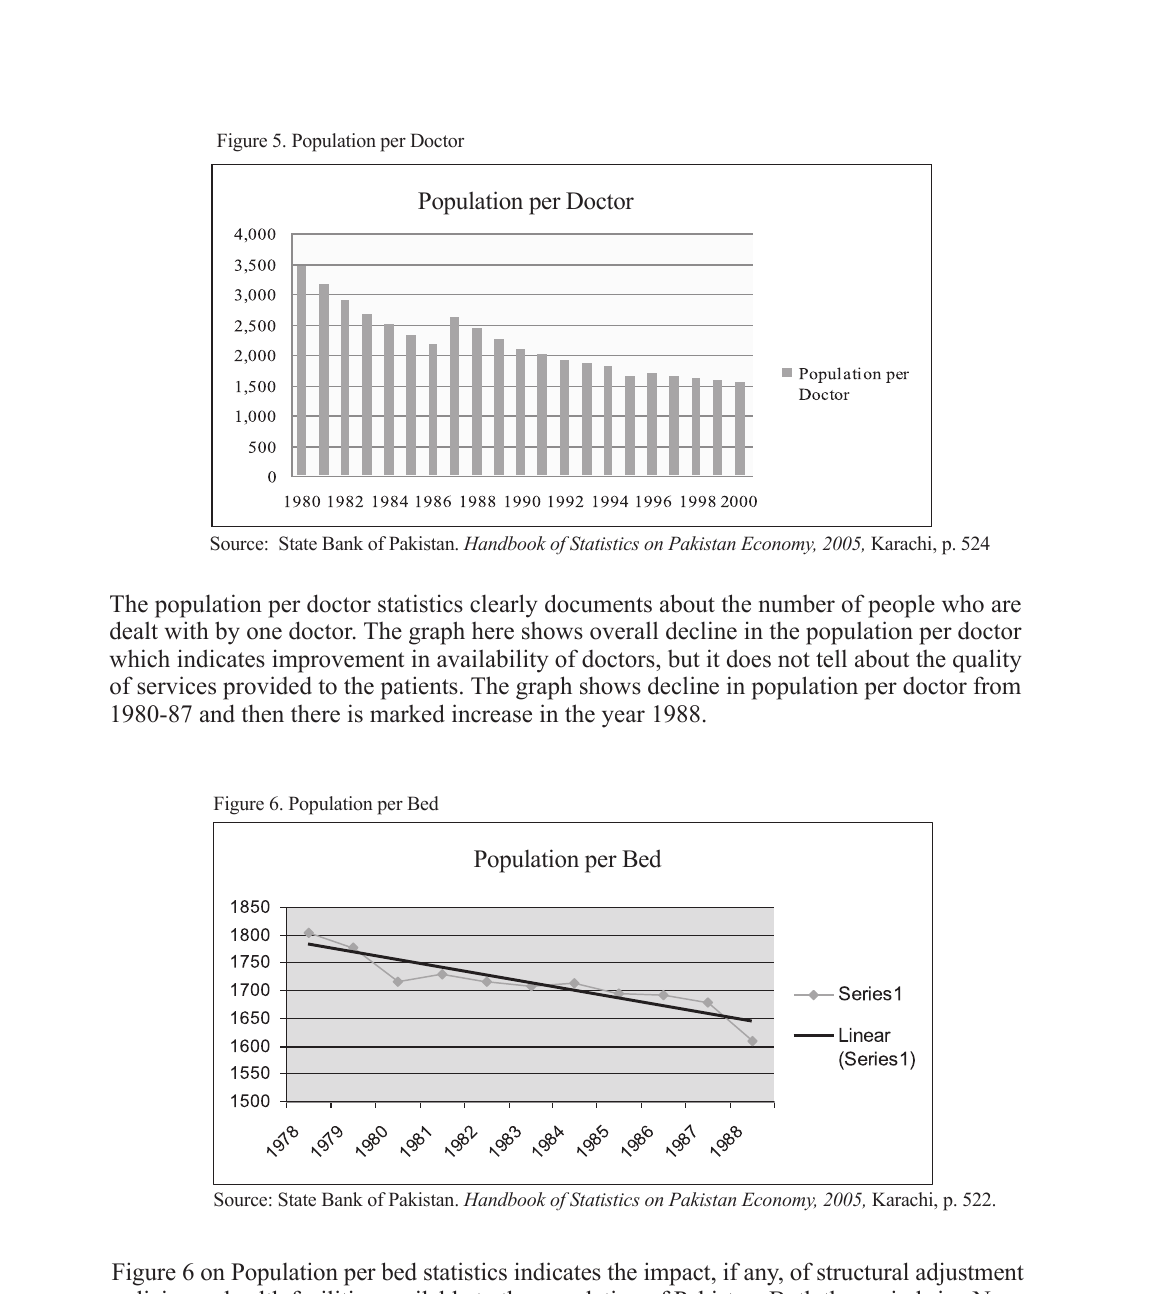
Figure 6 on Population per bed statistics indicates the impact, if any, of structural adjustment policies on health facilities available to the population of Pakistan. Both the periods i.e. Non-IMF and IMF periods show a declining trend in Population per bed, hence implying that theoverall health facilities improved in both IMF and non-IMF era with similar trends.